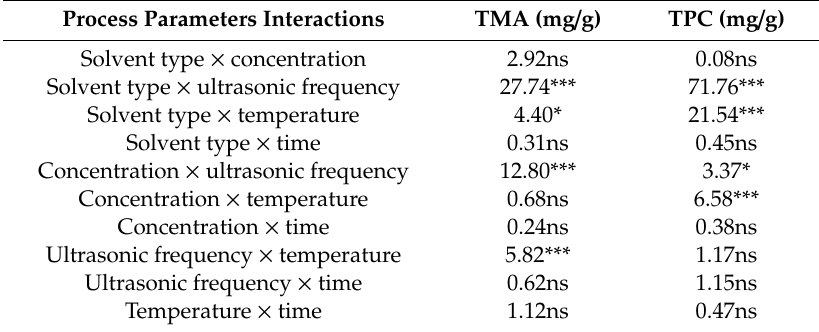
Table 3. Interactions between process parameters and their statistical